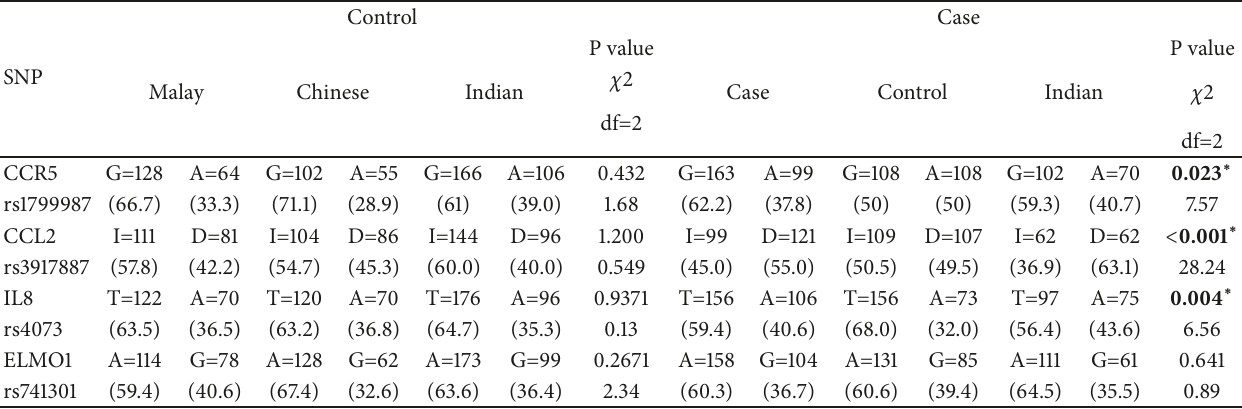
Table 5: Differences in the frequencies of allele distribution among the